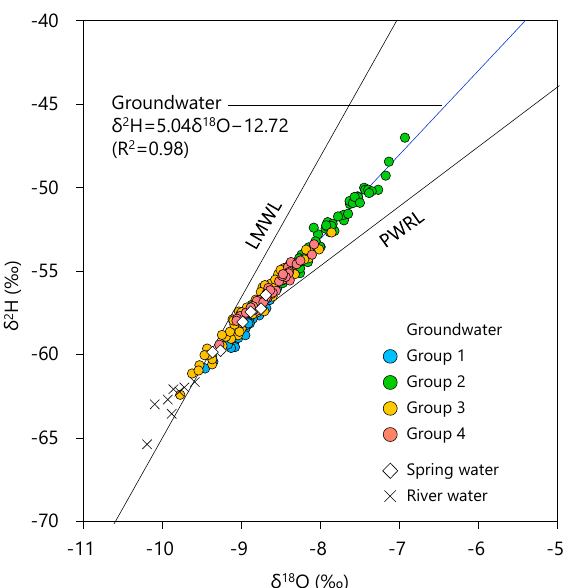
Figure 14. Relationship between δ 18 O and δ 2 H of the four groundwater groups. LMWL and PWRL are the local meteoric water line and the paddy water regression line, respectively, as shown in Figure 8.